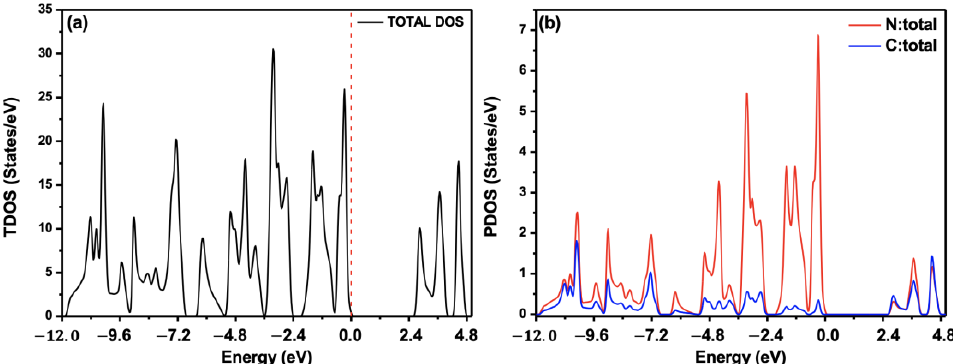
Figure 9. ( a ) Total density of states (TDOS) and ( b ) partial density of states (PDOS) plots of gCN bulk and monolayer.